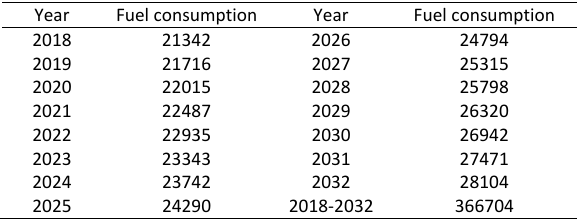
Table 8: Evaluated the fuel consumption in SWCTT in different district of Tehran from 2018 ‐ 2032 (thousand L)